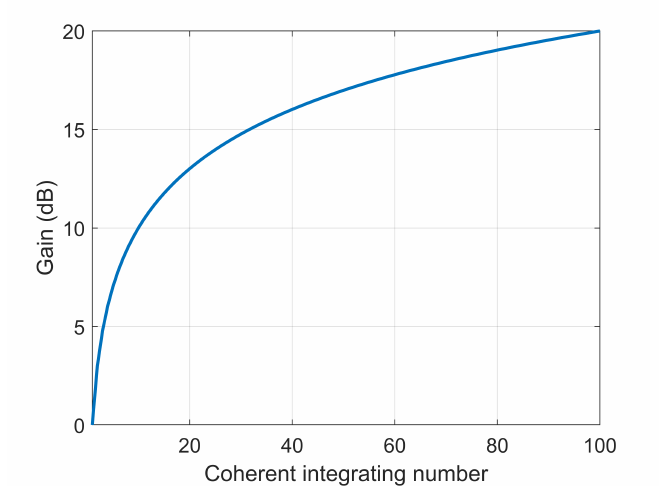
Figure 7. The coherent gain versus coherent integrating